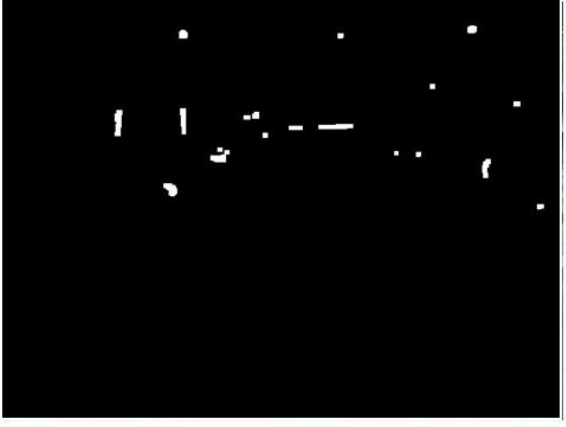
Fig. 4. Result image with bounding box of the candidate regions after filtering based on dimension properties. Notice that there are many false alarms but all the four candidate regions of traffic lights are detected.